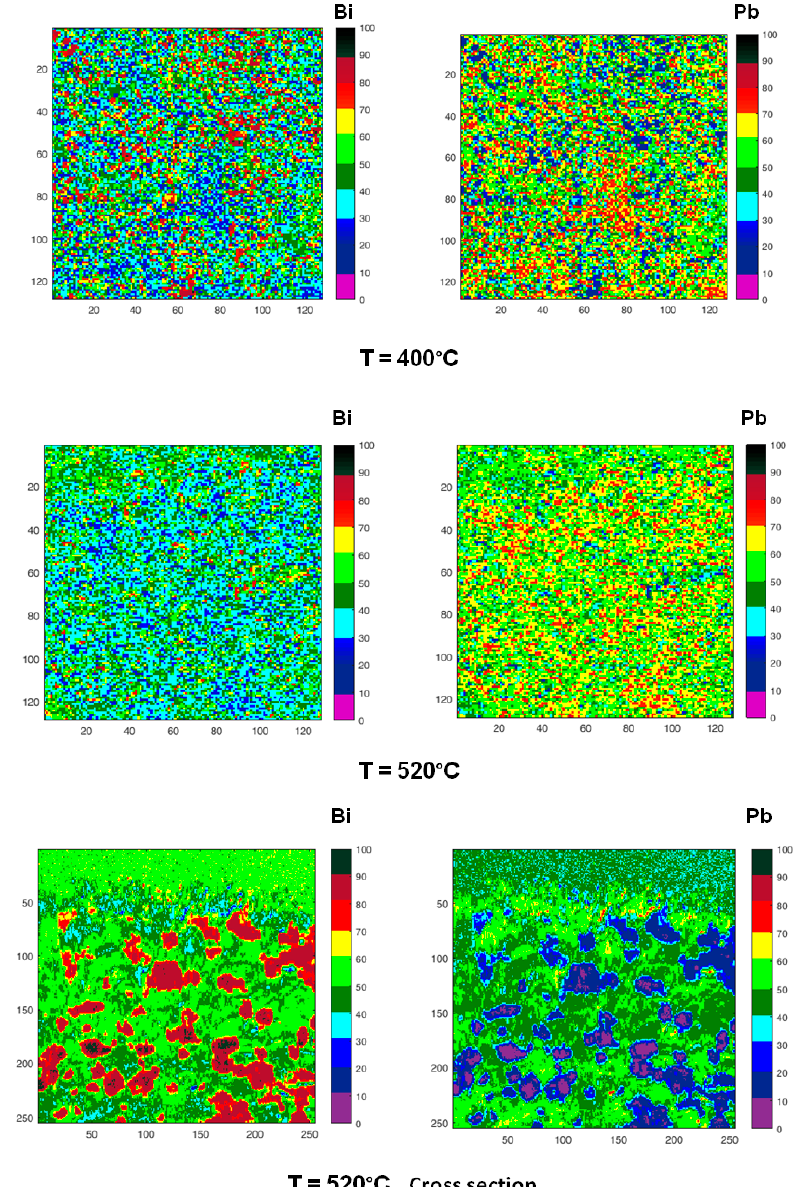
Figure 10. Chemical maps of Bi (left column) and Pb (right column) collected on the sample surface after quenching from increasing temperatures (200, 315, 400, 520 °C). The last two micrographs have been collected on the cross-section of the sample quenched from 520 °C. All images show an area 100 µm × 100 µm except those recorded on the cross-section (50 µm × 50 µm). Numbers on the scale axis indicate the acquisition channels.